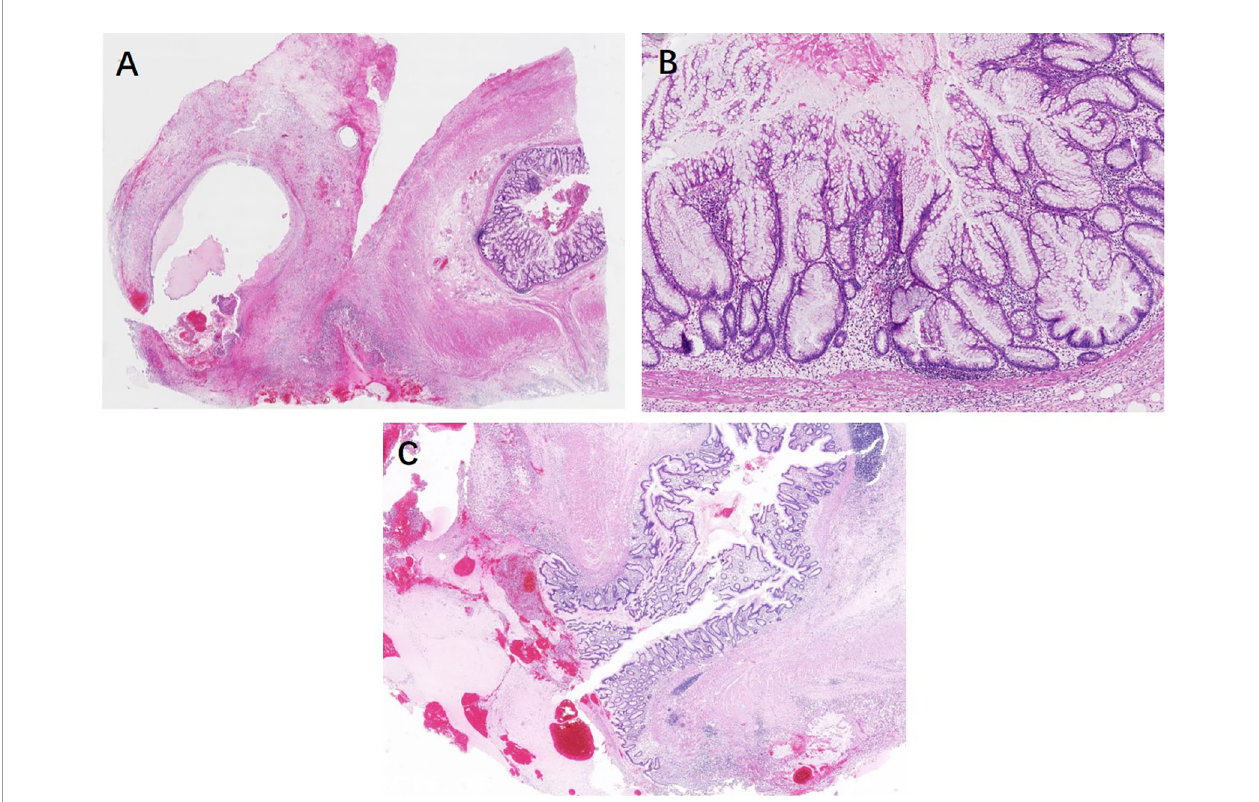
FIGURE 3 | Serrated lesions with dysplasia coexistence of ruptured diverticula. (A) The mucus cyst is apparently found within the mesoappendix at the tip. (B) On higher power, the mucosa is lined with distorted serrated crypts with low-grade dysplasia. (C) On the other sections of the entirely submitted appendix, the ruptured diverticulum lined with a relatively normal mucosa rules out a low-grade appendiceal mucinous